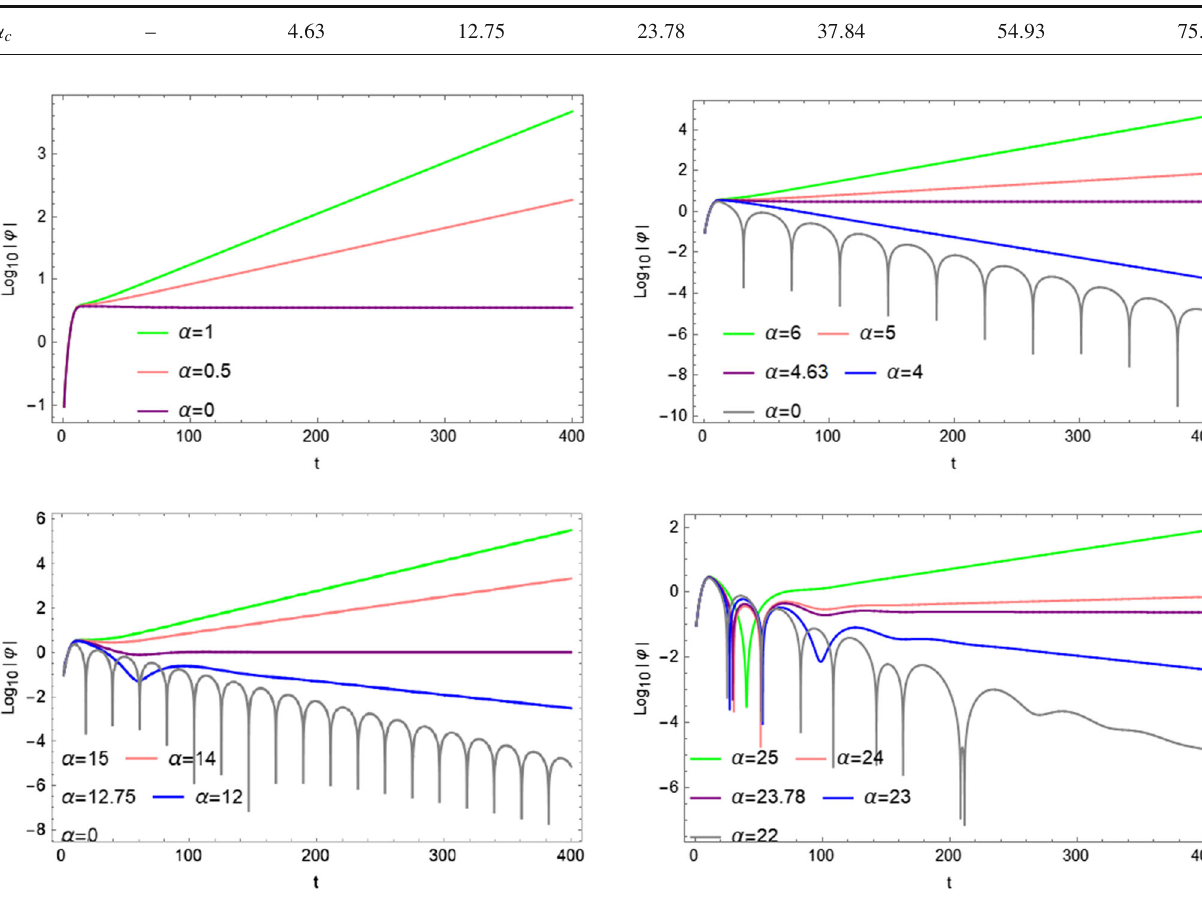
Fig. 2 The time evolution of the perturbation modes with (cid:4) = 1, (cid:4) = 2 and (cid:4) = 3 from left to